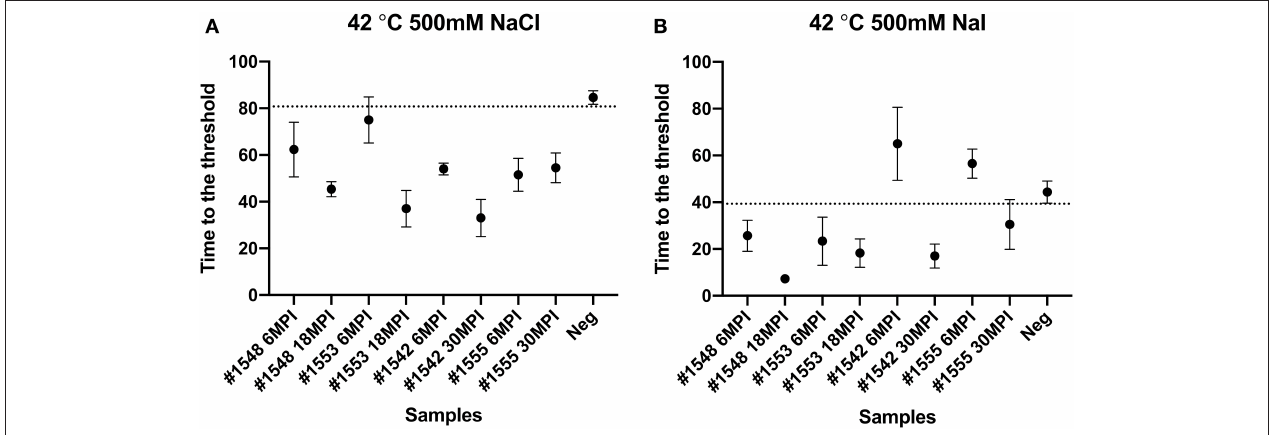
FIGURE 9 | Comparison of lag time analysis of RT-QuIC reactions seeded with biopsy fecal homogenates from preclinical white-tailed deer in the presence of 500mM NaCl (A) or NaI (B) . Circles represent the mean and the bars represent SD of four replicate reactions. The horizontal line is the cutoff.